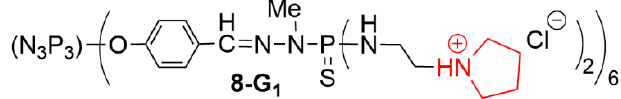
Figure 12. First generation dendrimer bearing pyrrolidinium terminal functions.